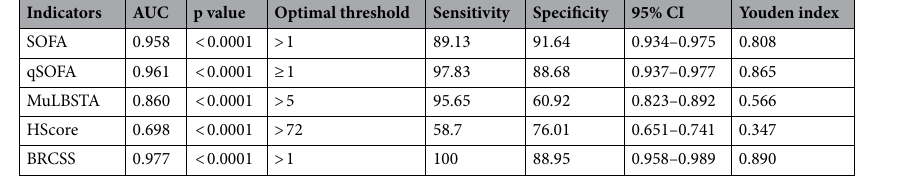
Table 4. The AUC and optimal thresholds of each independent risk or protection factors for score system of all patients according to the severity of disease. SOFA Sequential organ failure assessment score, qSOFA quick sequential organ failure assessment score, MuLBSTA multilobularinfiltration, hypo-lymphocytosis, bacterial coinfection, smoking history, hyper-tension and age score, HScore hemophagocytosis score, BRCSS Brescia respiratory covid severity scale.